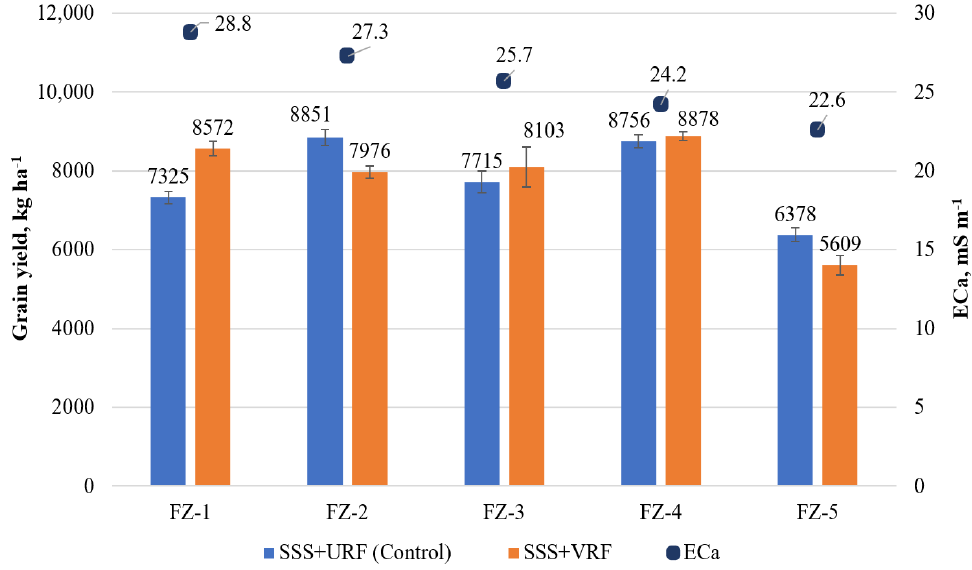
Figure 5. Interface of grain yield with electrical conductivity in different field zones.